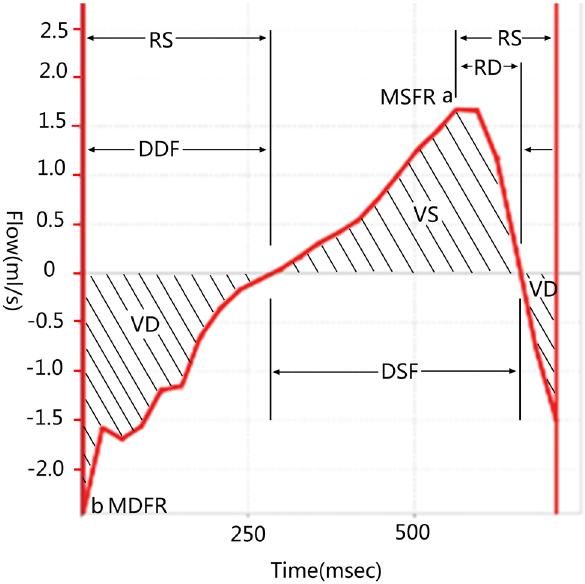
Figure 2. Example of a CSF flow rate waveform from one of the volunteers, with a graphical representation for most parameters analyzed. Positive waveform values correspond to systolic (craniocaudal orientation) CSF flow, while negative values correspond to diastolic (caudocranial orientation) CSF flow. R–D the interval ranging from a R wave to the onset of the diastolic CSF flow, R–S the interval ranging from a R wave to the onset of the systolic CSF flow, DSF duration of the CSF systolic flow, DDF duration of the CSF diastolic flow. a peak of the systolic curve, representing the maximum systolic flow rate (MSFR), b trough of the diastolic curve, representing the maximum diastolic flow rate (MDFR), VS area under a systolic curve, representing the CSF flow volume during the systole, VD area under a diastolic curve, representing the CSF flow volume during the diastole. In addition, some parameters obtained by calculations, the average systolic flow rate (ASFR) = VS/DSF, the average diastolic flow rate (ADFR) = VD/DDF, and the CSF stroke volume during the entire cardiac cycle (net flow volume, NV) = VS +